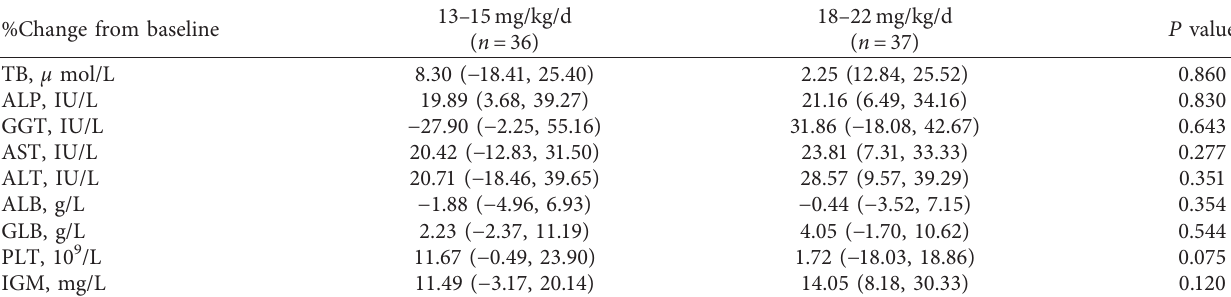
Table 7: Percentage of biochemical relative changes from baseline at